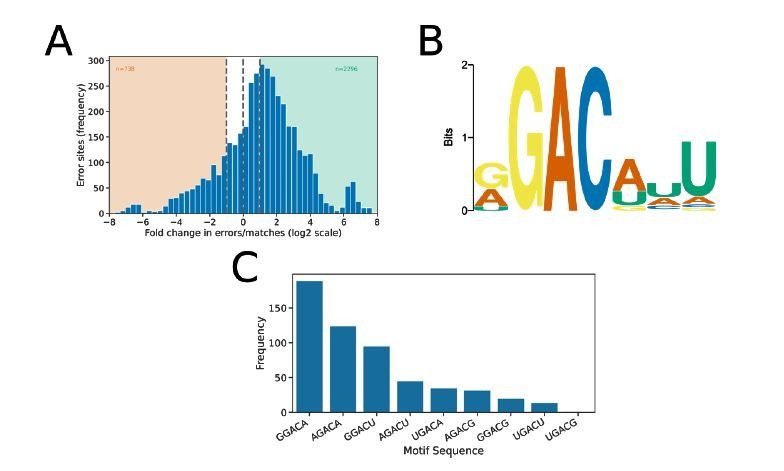
Differential error rate analysis of S. cerevisiae SK1 WT vs ime4.(a) Histogram showing the log2 fold change in the ratio of errors to reference matches at bases with a significant change in error profile in ime4 mutant compared with wild type S. cerevisiae SK1. Orange and green shading indicates sites with increased and reduced errors in ime4, respectively. (b) Sequence logo showing the motif enriched at sites with reduced error rate in ime4. (c) Frequency of m6A motifs detected at ime4 reduced error sites, as detected by FIMO using the motif detected de novode novo by MEME and an FDR threshold of 0.1.